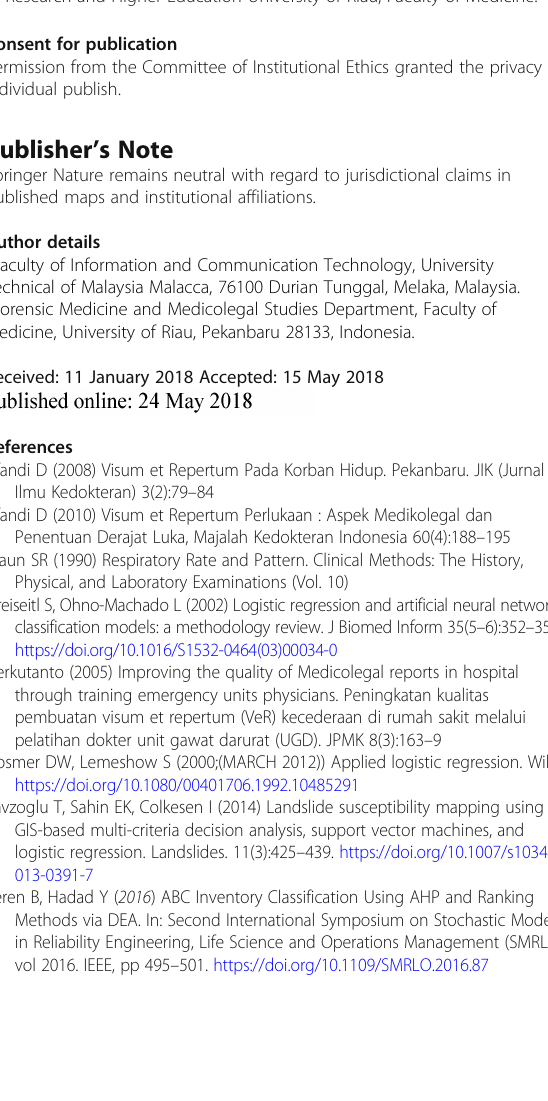
Fig. 4 Probability of Degree Injury (1 if DIV ≥ 2 and – if DIV <